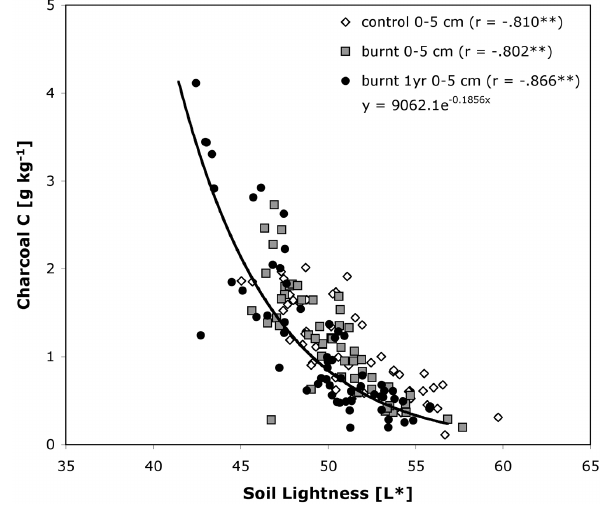
Fig. 2. The values for charcoal C concentration and soil lightness in samples from all investigated soil depths (0–5cm) show significant and high correlations. The trendline and the equation are given for the sample set burnt